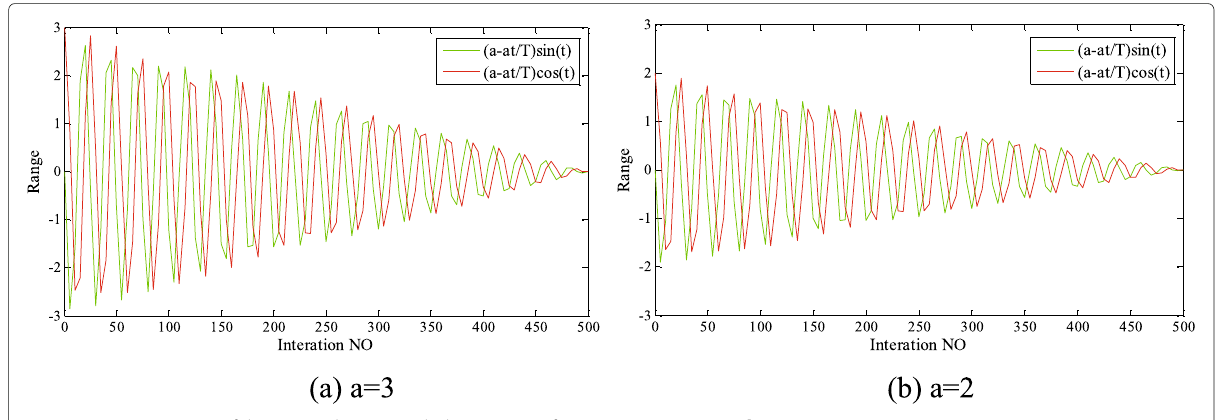
Fig. 3 Decreasing range of the sine and cosine with the increase of iterations [37]. a a = 3, b a = 2